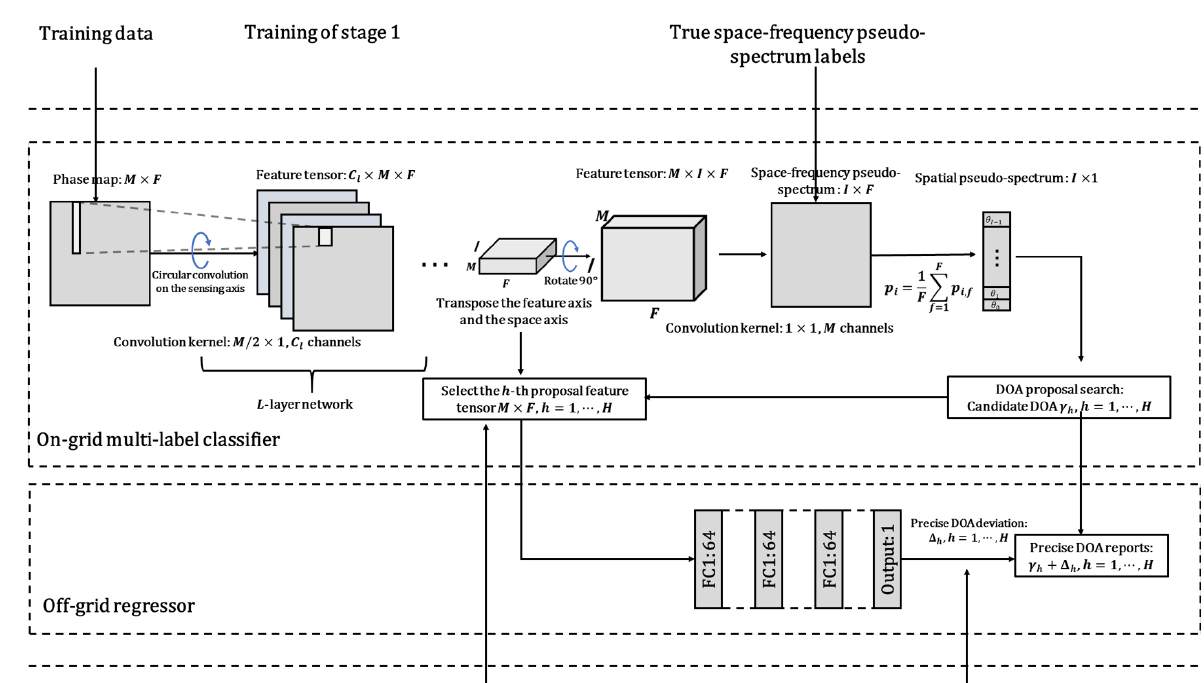
Figure 2. Proposed